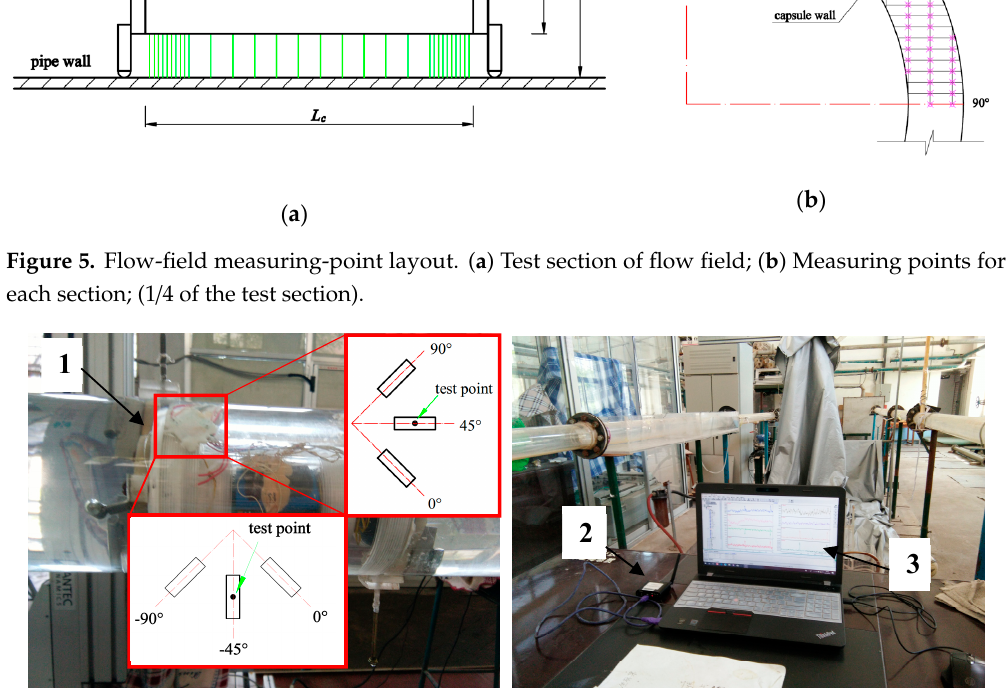
Figure 6. Experiment devices and instruments. 1, main engine of force-measurement system; 2, gateway of force measurement system; 3, system software TSTDAS